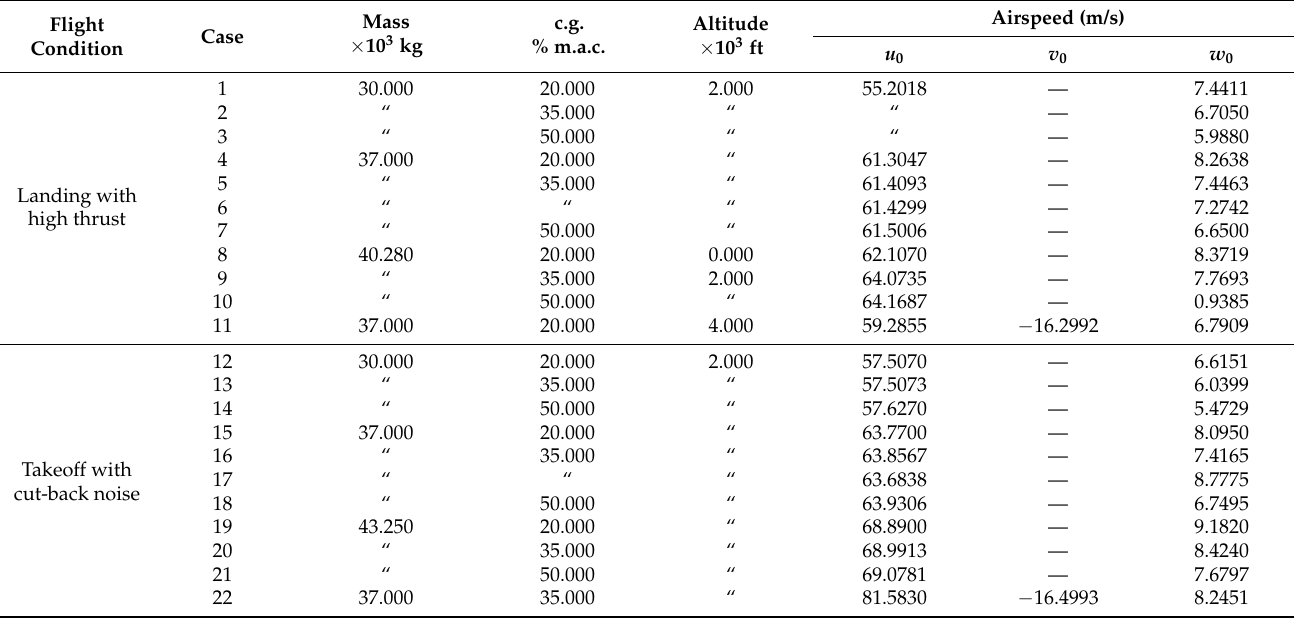
Table 4. V-tailed jet airliner flight conditions.